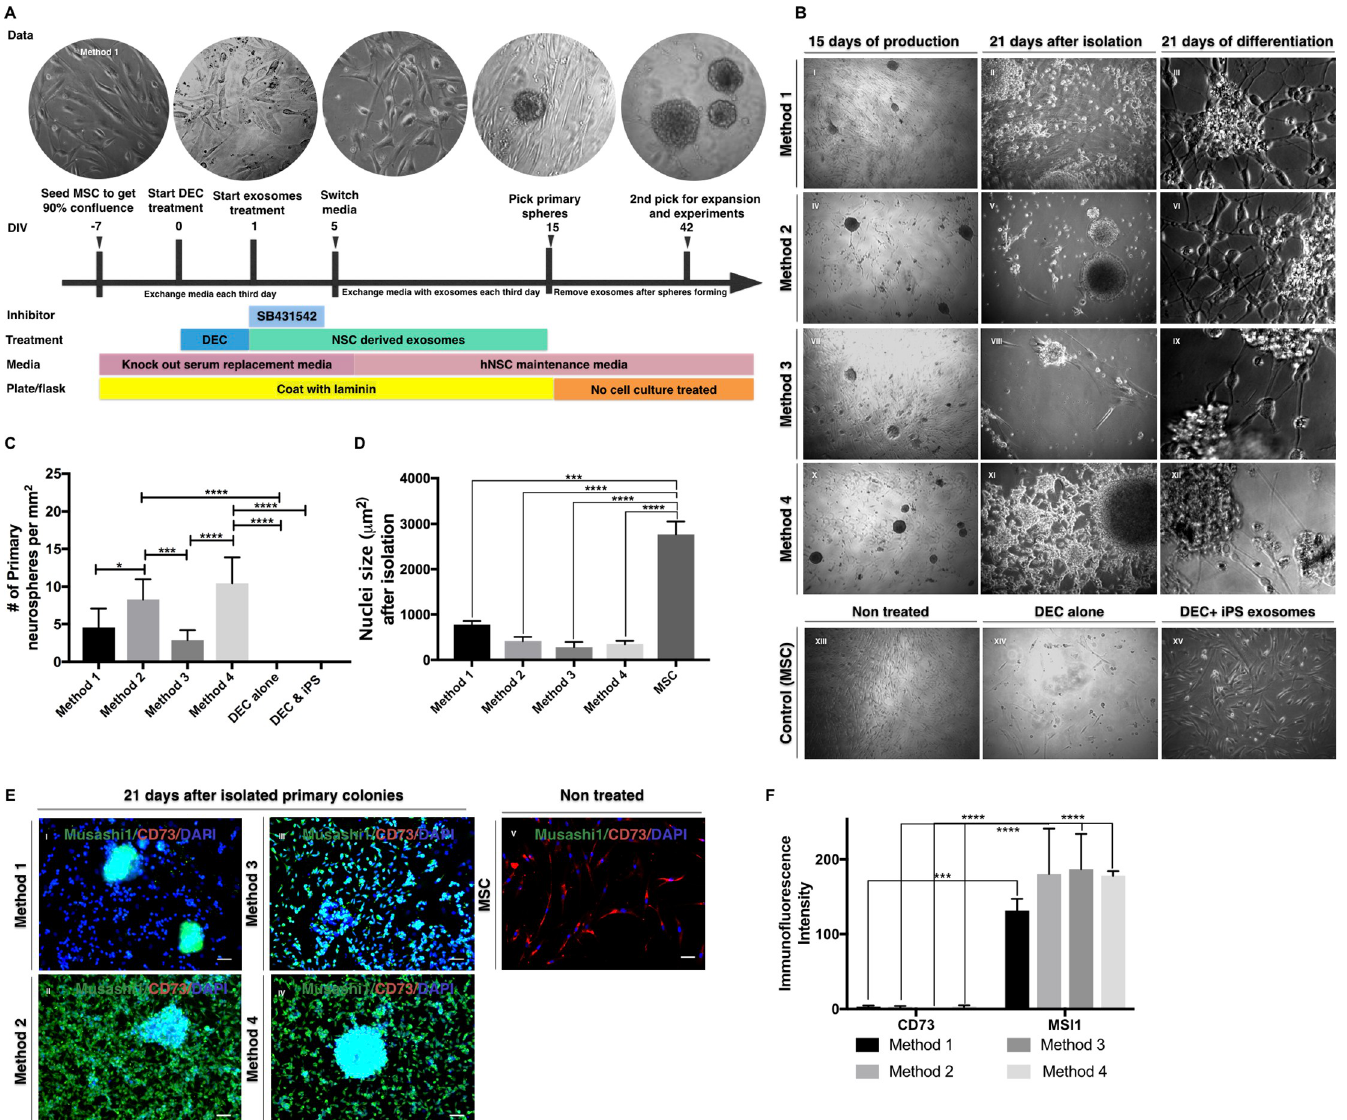
Fig 1. Generation of cells expressing neural markers under Xeno-free conditions. Panel A shows the schematic procedure to produce iNSCs from MSCs. Method 1; treatment with NSCs derived exosomes alone. Method 2; treatment with NSCs derived exosomes in the presence of 10 μ M decitabine. Method 3; treatment with exosomes derived from both NSCs and iPS cells. Method 4; treatment with exosomes derived from both NSCs and iPS cells in the presence of 10 μ M decitabine. Panel B shows phase-contrast microscopic images for 3 different stages, production (15 DIV), Isolation (21 DIV), and differentiation in various methods 1–4. XIII. No treatment: without any treatment. XIV. Treatment alone: decitabine treated MSCs. XV. Treatment + iPS exosome: MSCs treated with iPS cells derived exosome with decitabine treatment are shown as controls. Panel C shows the number of primary neurospheres formed at 21 DIV. The decitabine treated cells developed significantly higher numbers of spheroids as compared to those without the treatment. Without NSCs derived exosome treatment, any spheroid formation was not observed. Panel D shows the differences in the nucleic size of the cells at 21 DIV. The iNSC produced in all four methods showed significantly reduced nuclei size as compared to the naive MSCs. Panel E shows immunocytochemistry of iNSCs and MSCs (control) after differentiation for NSC marker, Musashi (MSI1, green), and MSC marker (CD73, Red). The nuclei were counterstained with DAPI (Blue). The scale bar is 50 μ m. Panel F shows semi-quantitative fluorescence intensity measurement by Image J. � P < 0.05, �� P < 0.01, ��� P < 0.005, ���� P <